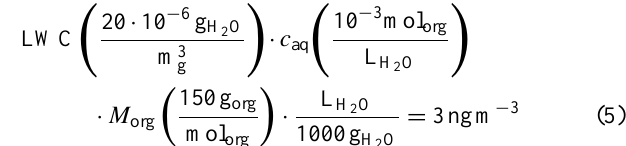
Figure 6. Reduction of solubility due to ionic strength ( K ∗ as a function of Setchenov coefficient K s according to Eq. (4). The white vertical lines show the approximate range of K s values for ketones (Wang et al., 2014). Molalities of ∼ 2.7molkg − 1 and ∼ 6.2molkg − 1 (white boxes) refer to saturated ammonium sulfate and sodium chloride solutions,